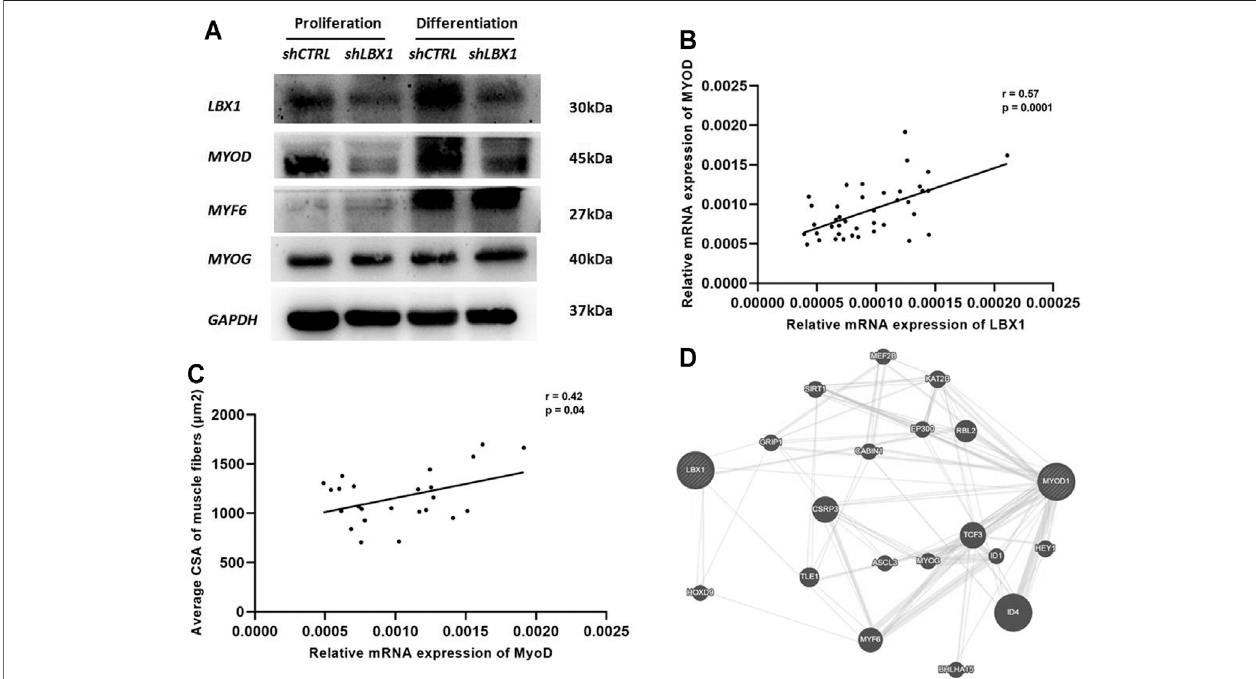
FIGURE 5 | MyoD was involved in the regulation of LBX1 on myogenesis in AIS. (A) Protein expression level of myogenic markers in MSCs with LBX1 knockdown was validated by western blot at proliferation and differentiation stages. GAPDH was used as internal control. For both proliferation and differentiation stages, a remarkablydecreased protein expression of MyoD wascon fi rmedinthe LBX1 -lentivirus-transfectedcells. (B) Tissueexpression analysisin48AISpatients showedthat the mRNA expression of LBX1 was positively correlated with the expression of MyoD ( r (cid:1) 0.57, p < 0.01). (C) The cross-sectional area (CSA) of myotube and the expression of MyoD were evaluated at the ninth day after MSC culture. The mRNA expression of MyoD was signi fi cantly correlated with the CSA of the type I fi ber ( r (cid:1) 0.42, p (cid:1) 0.04). (D) Functional pathway enrichment of differential genes was analyzed based on KEGG and BIOCARTA pathway databases. Here, we showed that there was a lack of direct interaction between LBX1 and MyoD